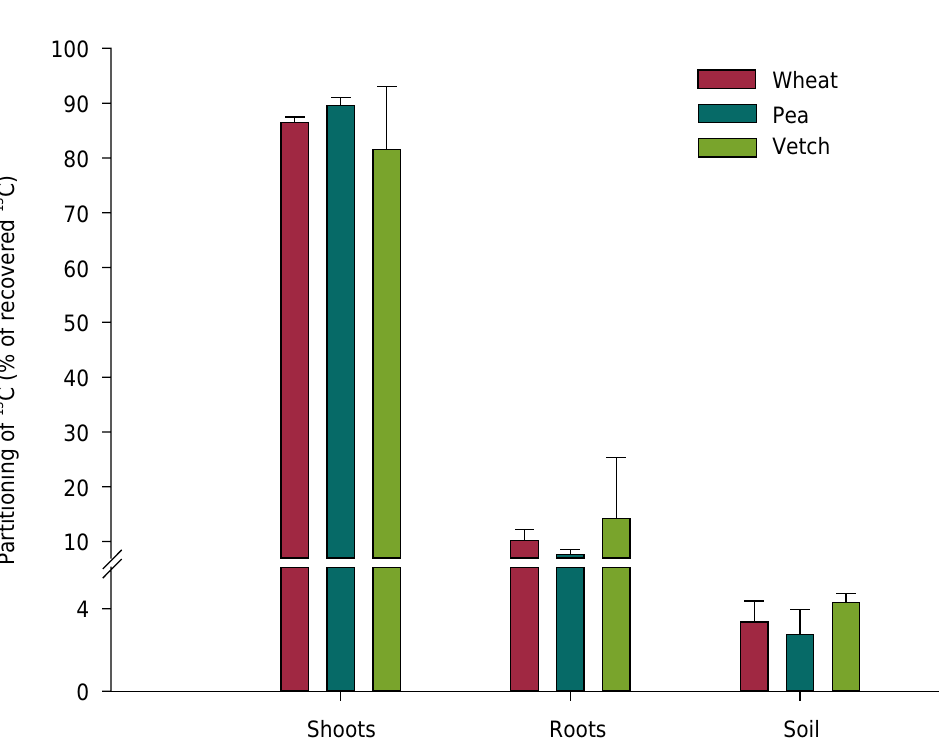
Figure 3. Partitioning of 13 C (% of recovered 13 C) in shoots, roots, and soil of three crop plants after repeat-pulse labeling under field conditions. The 13 C in shoots was the sum of the stems, leaves, pods, and grains for wheat and pea plants and the sum of stems and leaves for vetch plants. The error bar indicates the standard error ( n=